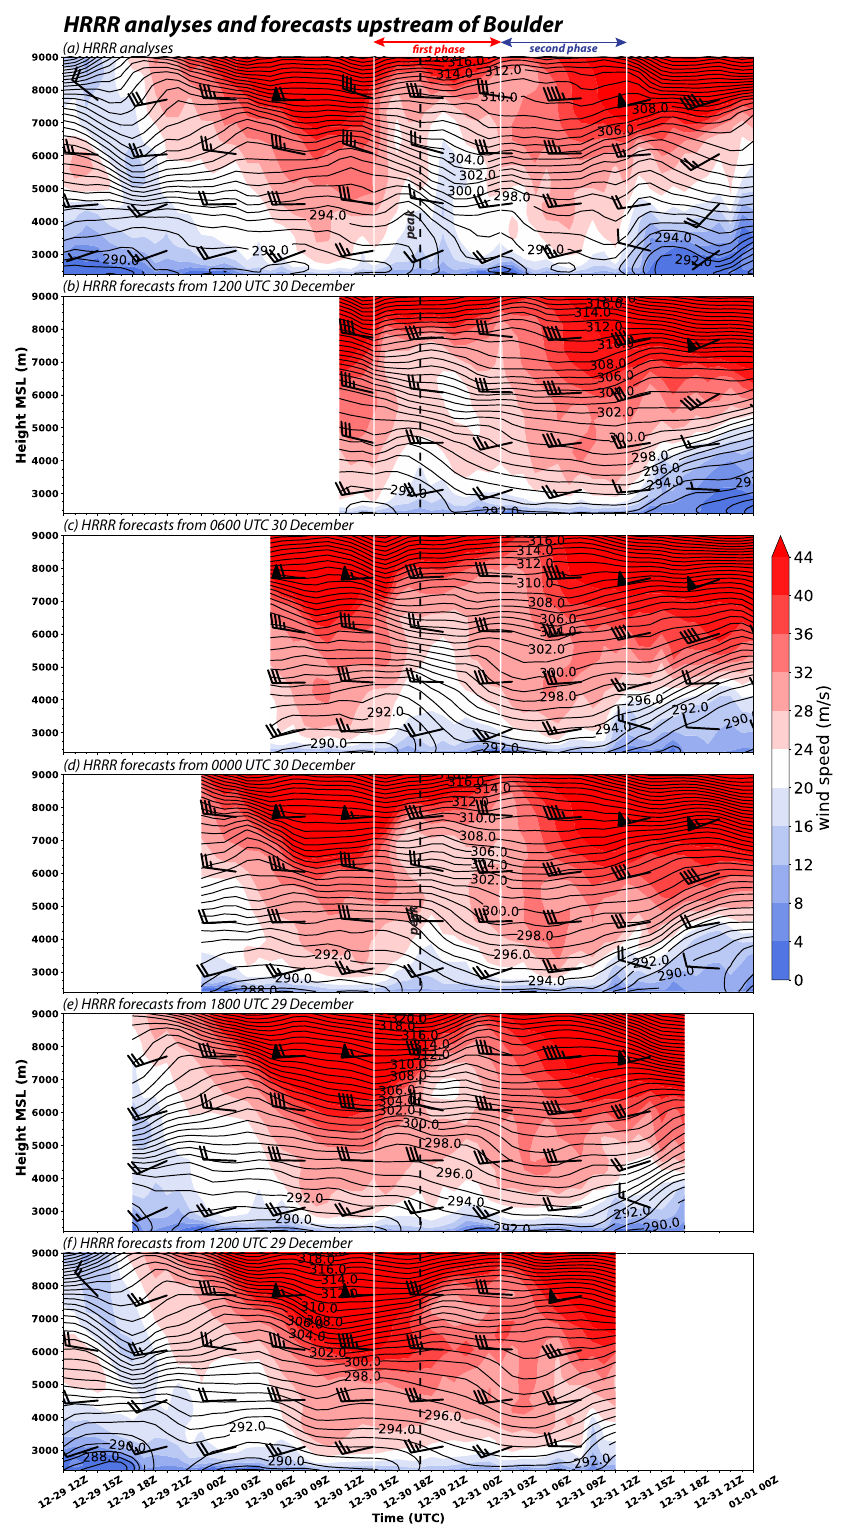
Figure 10. Similar to Figure 4 but showing the evolution of ( a ) analyses, and ( b – f ) forecasts from various HRRR cycles for the upstream location. Panels ( a ) and ( f ) repeat information from Figure 4 to provide additional context. Figure 11 superimposes vertical profiles of wind speed and potential temperature for our selected upstream location from various HRRR model runs, all valid at 1600